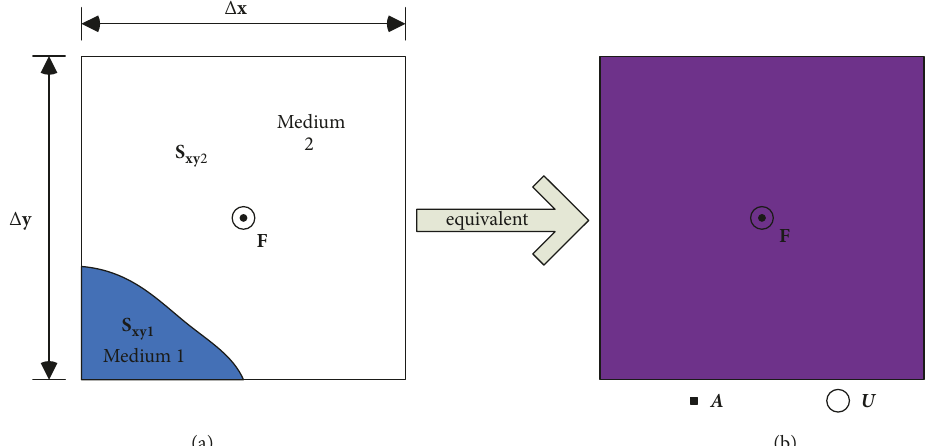
Figure 4: Schematic view for the equivalence of the medium parameters for a conformal grid point. (a) An actual subdivision grid. (b) A conformal